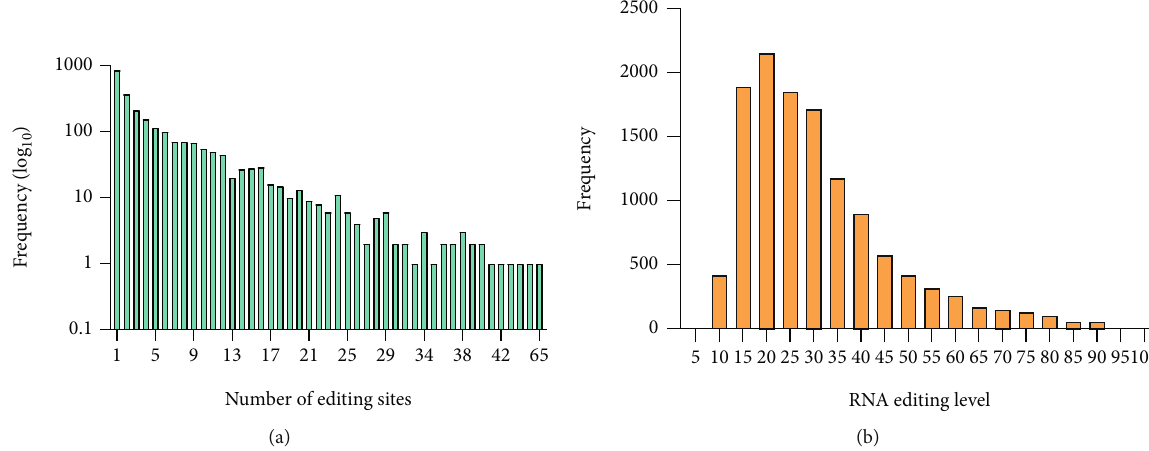
Figure 9: Frequency histogram of the number of editing sites (a) and frequency distribution plots of RNA editing levels